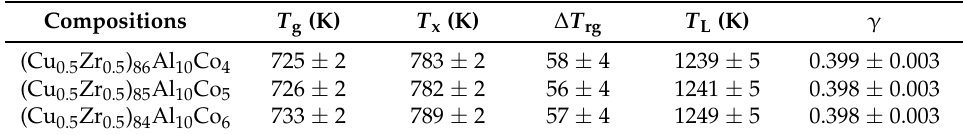
Figure 1. ( a ) XRD patterns of the (Cu 0.5 Zr 0.5 ) 90 − x Al 10 Co x ( x = 4, 5, and 6 at. %) BMGs with a diameter of 2 mm; ( b ) DSC curves of the as-cast BMGs at a heating rate of 20 K/min. Table 1. Thermal parameters of the as-cast (Cu 0.5 Zr 0.5 ) 90 − x Al 10 Co x ( x = 4, 5, and 6 at. %)